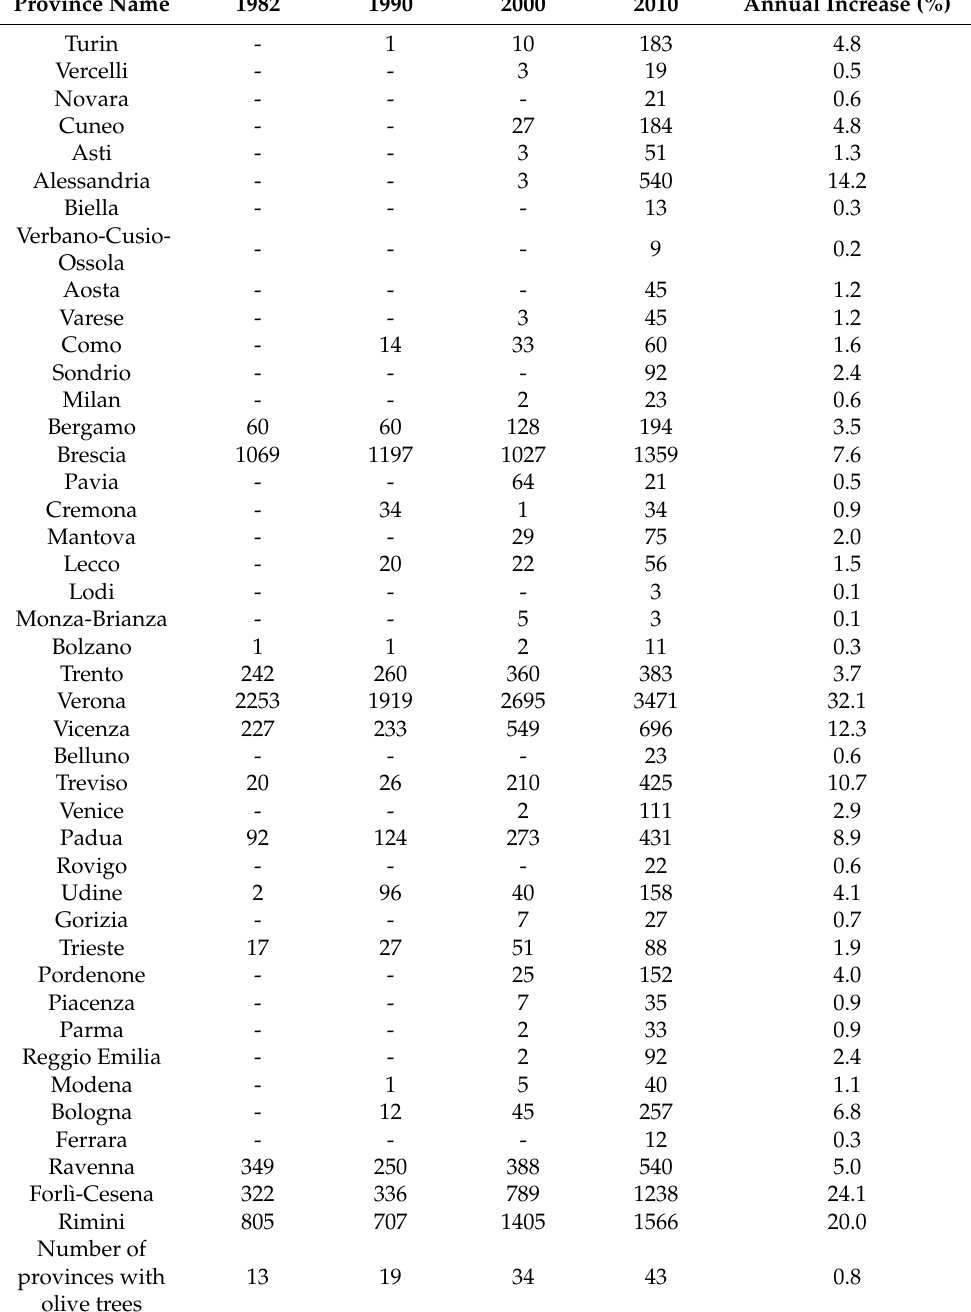
Table 4. Surface area (hectares) of the olive tree in Northern Italy by province and census